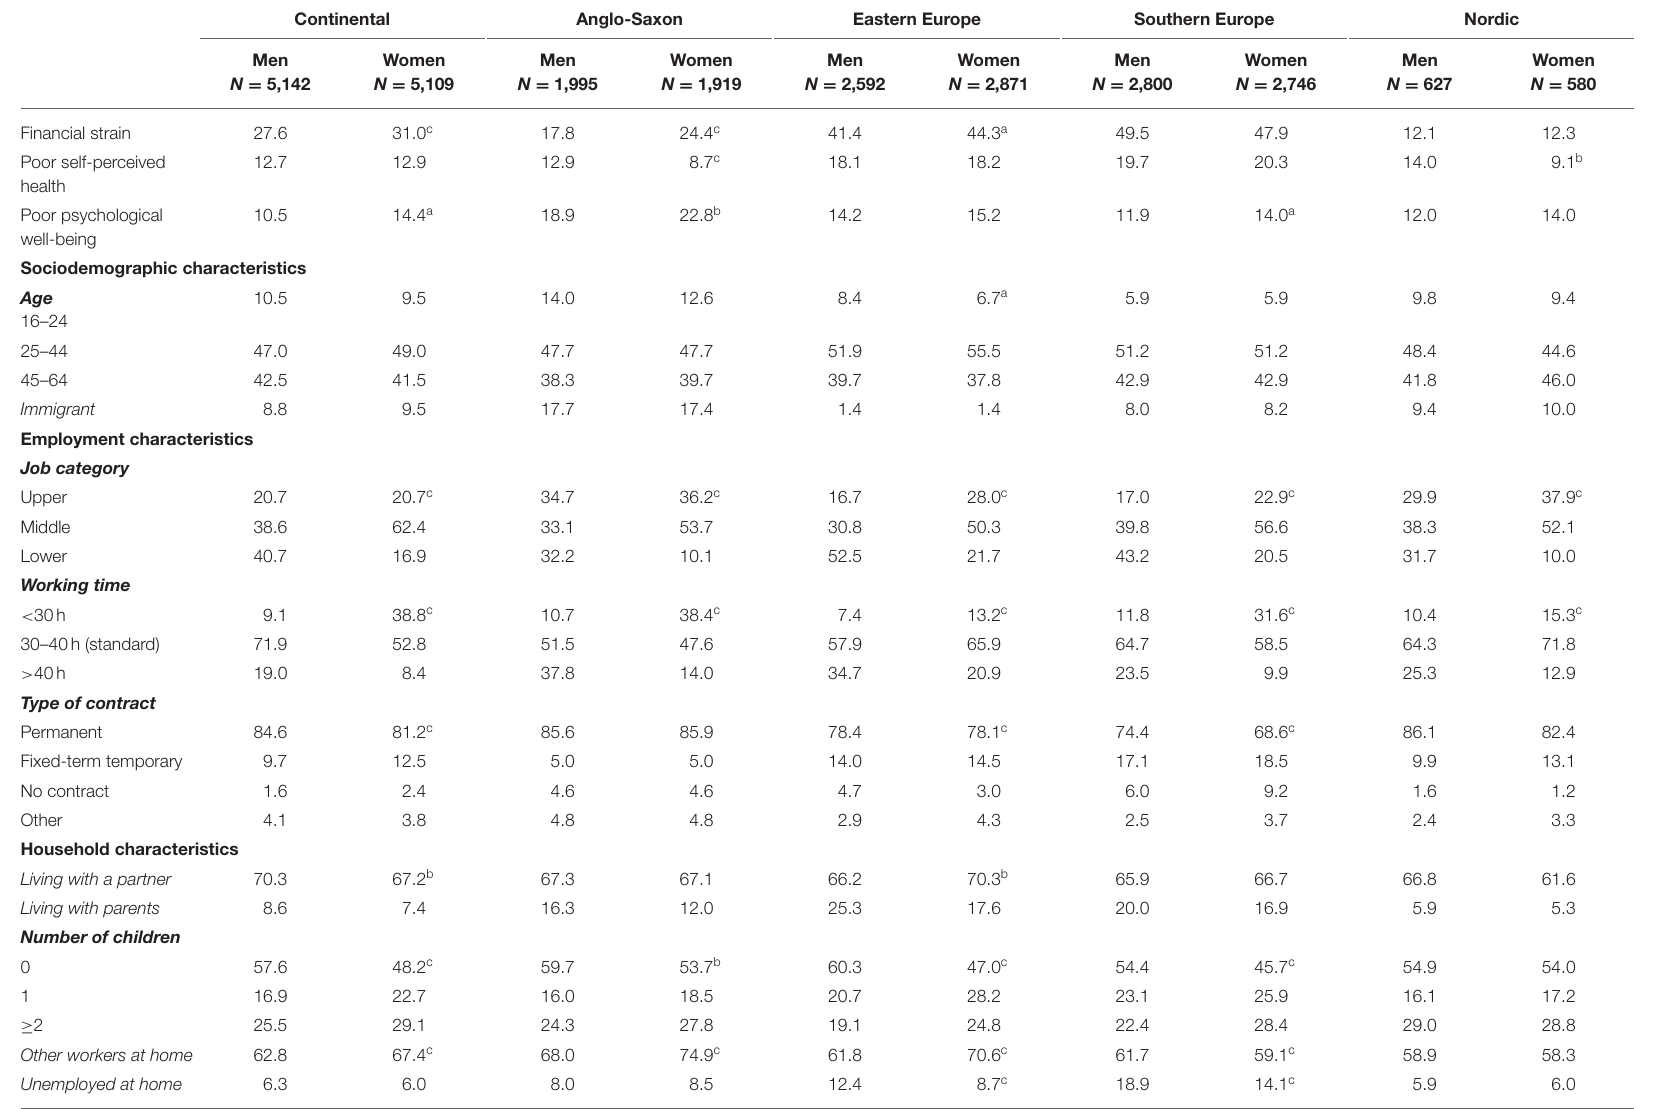
TABLE 1 | General description of the population by sex and welfare state typology. Continental Anglo-Saxon Eastern Europe Southern Europe